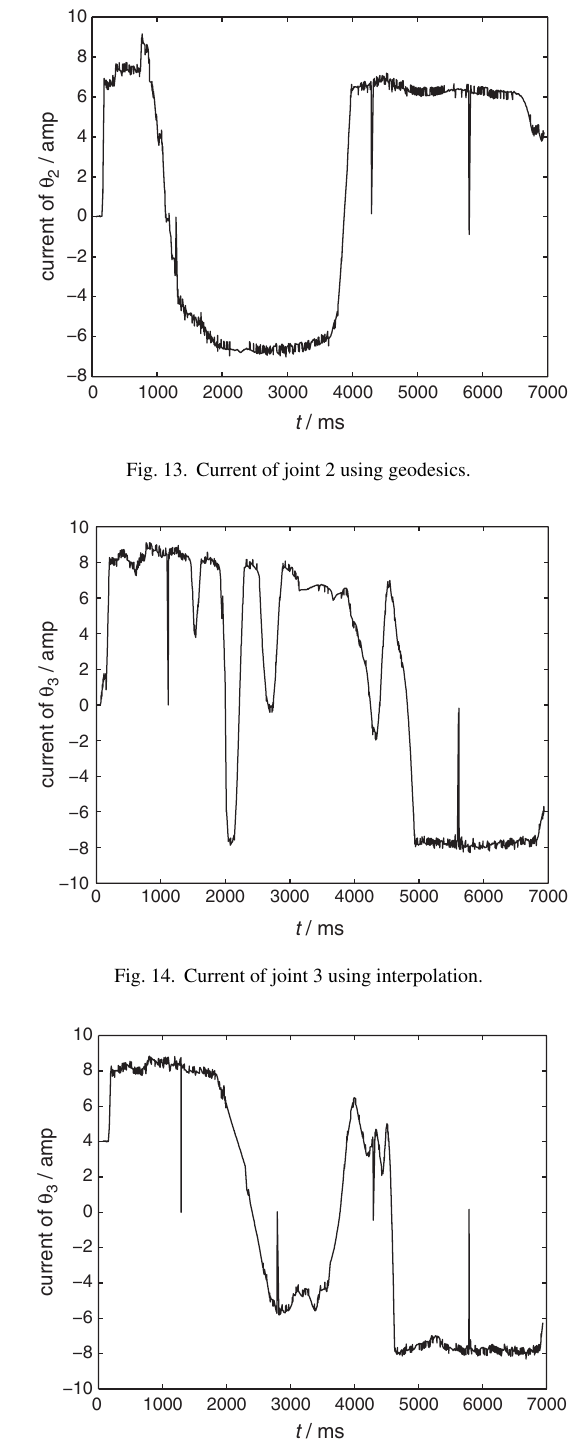
Fig. 15. Current of joint 3 using